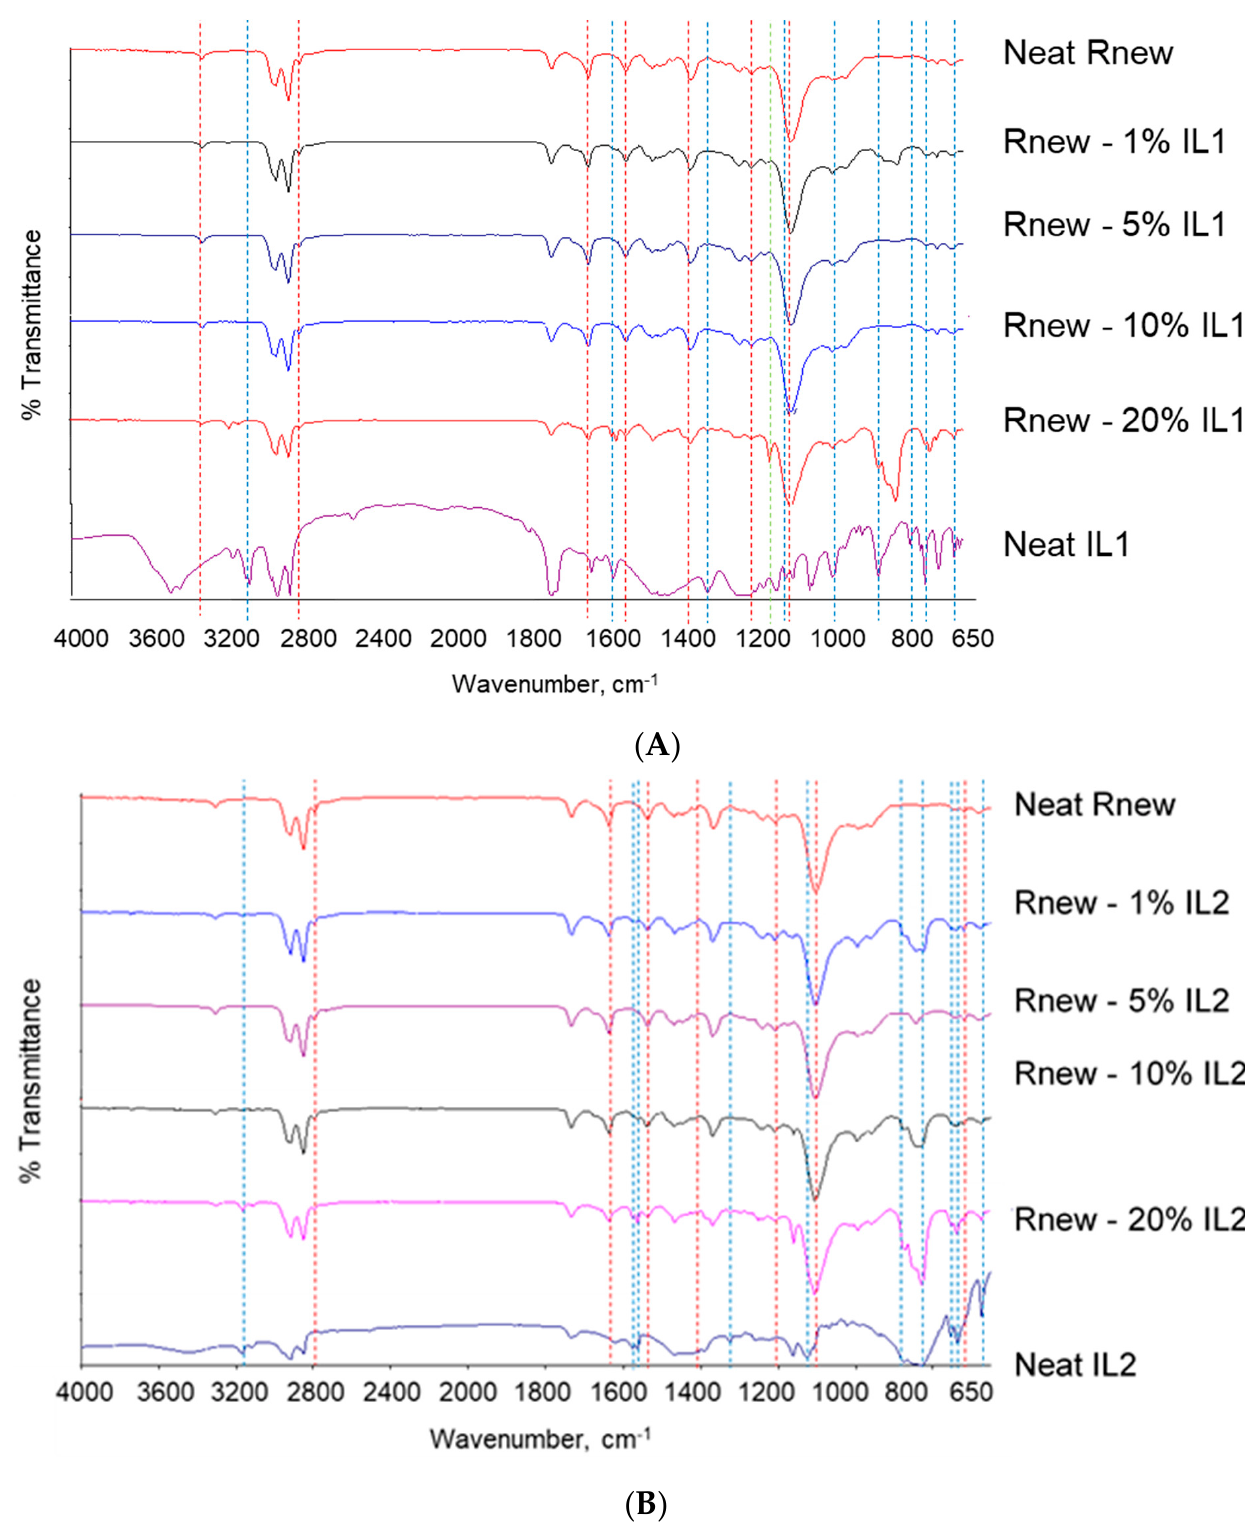
Figure 2. FT-IR spectra for Pebax ® Rnew and Pebax ® Rnew composite membranes. ( A ) Samples containing IL1 (HdmimDMSIP); ( B ) Samples containing IL2 (OOMmimPF 6 ). Red dashed lines identify characteristic bands of the neat copolymer, while blue dashed lines identify characteristic bands of the neat ILs.